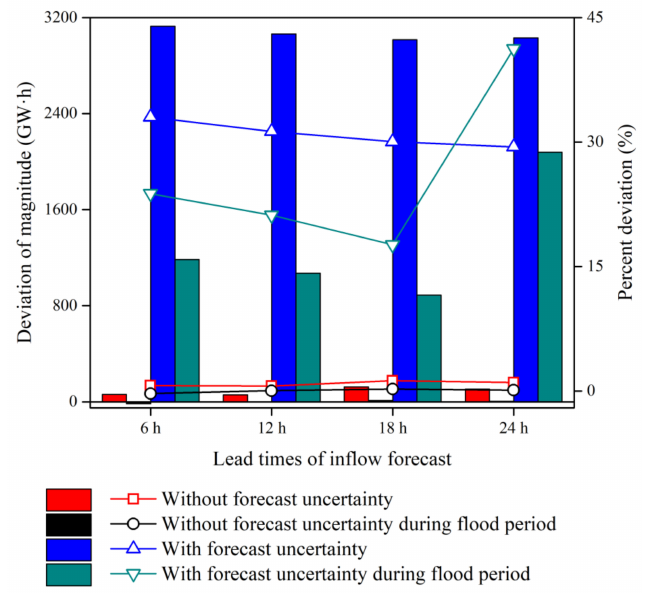
Figure 12. Total electricity curtailment as a magnitude and a percentage of the ensemble inflow fore- cast (with the forecast uncertainty considered) and the raw inflow forecast (without the consideration of the forecast uncertainty) over the entire study period and flood period